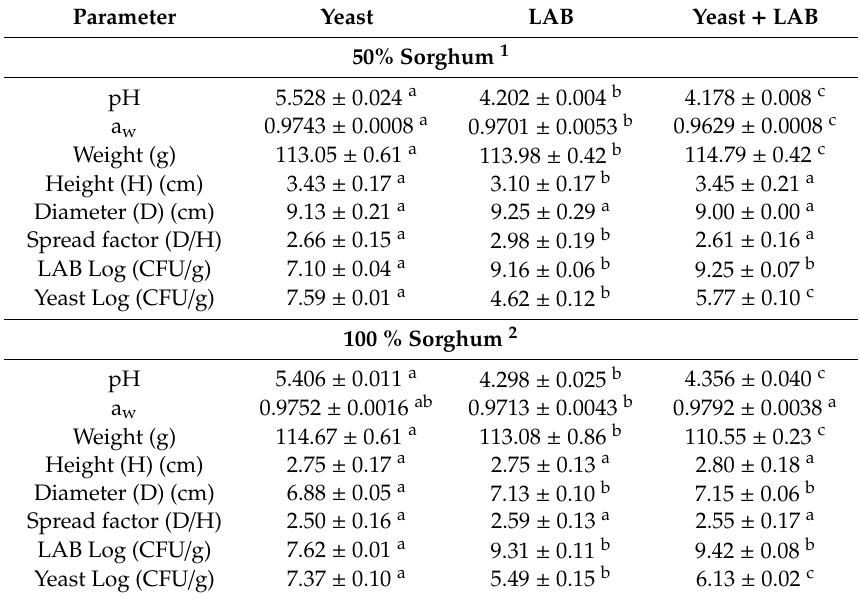
Table 2. Summary of the parameters measured after 24 h of incubation of the dough containing di ff erent concentrations of sorghum